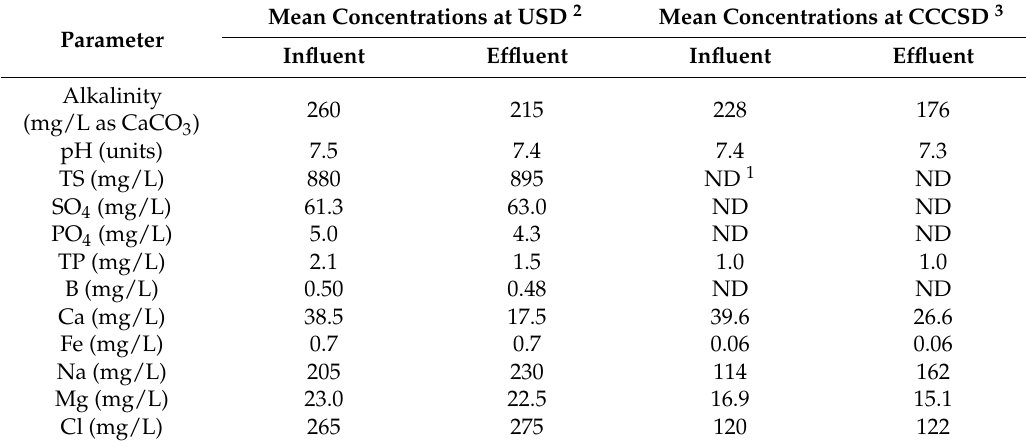
Table 3. General inlet and effluent water quality characteristics of pilot-plant treatment system from bi-monthly sampling during study